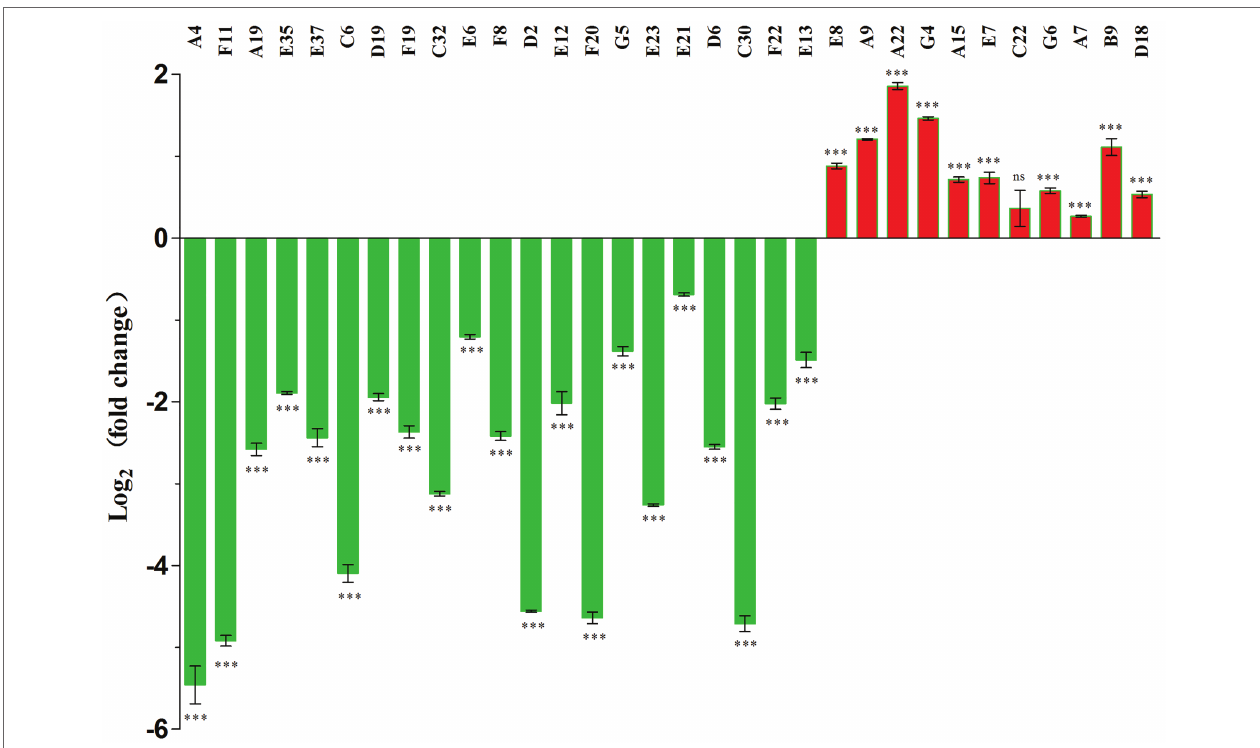
FIGURE 1 | Evaluation of the pigA expression level in 32 mutant strains with different genes inserted by the Tn5 transposon. Numbers from A4 to D18 in the above figure represent the mutants chosen for qPCR. Means ± SDs from three independent experiments are shown. Significant differences by unpaired t -test between the mutant strains and wild type strain are shown as follows: *** p < 0.001, and ns, no